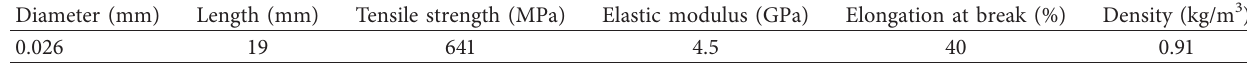
Table 2: Physical properties of polypropylene fiber.